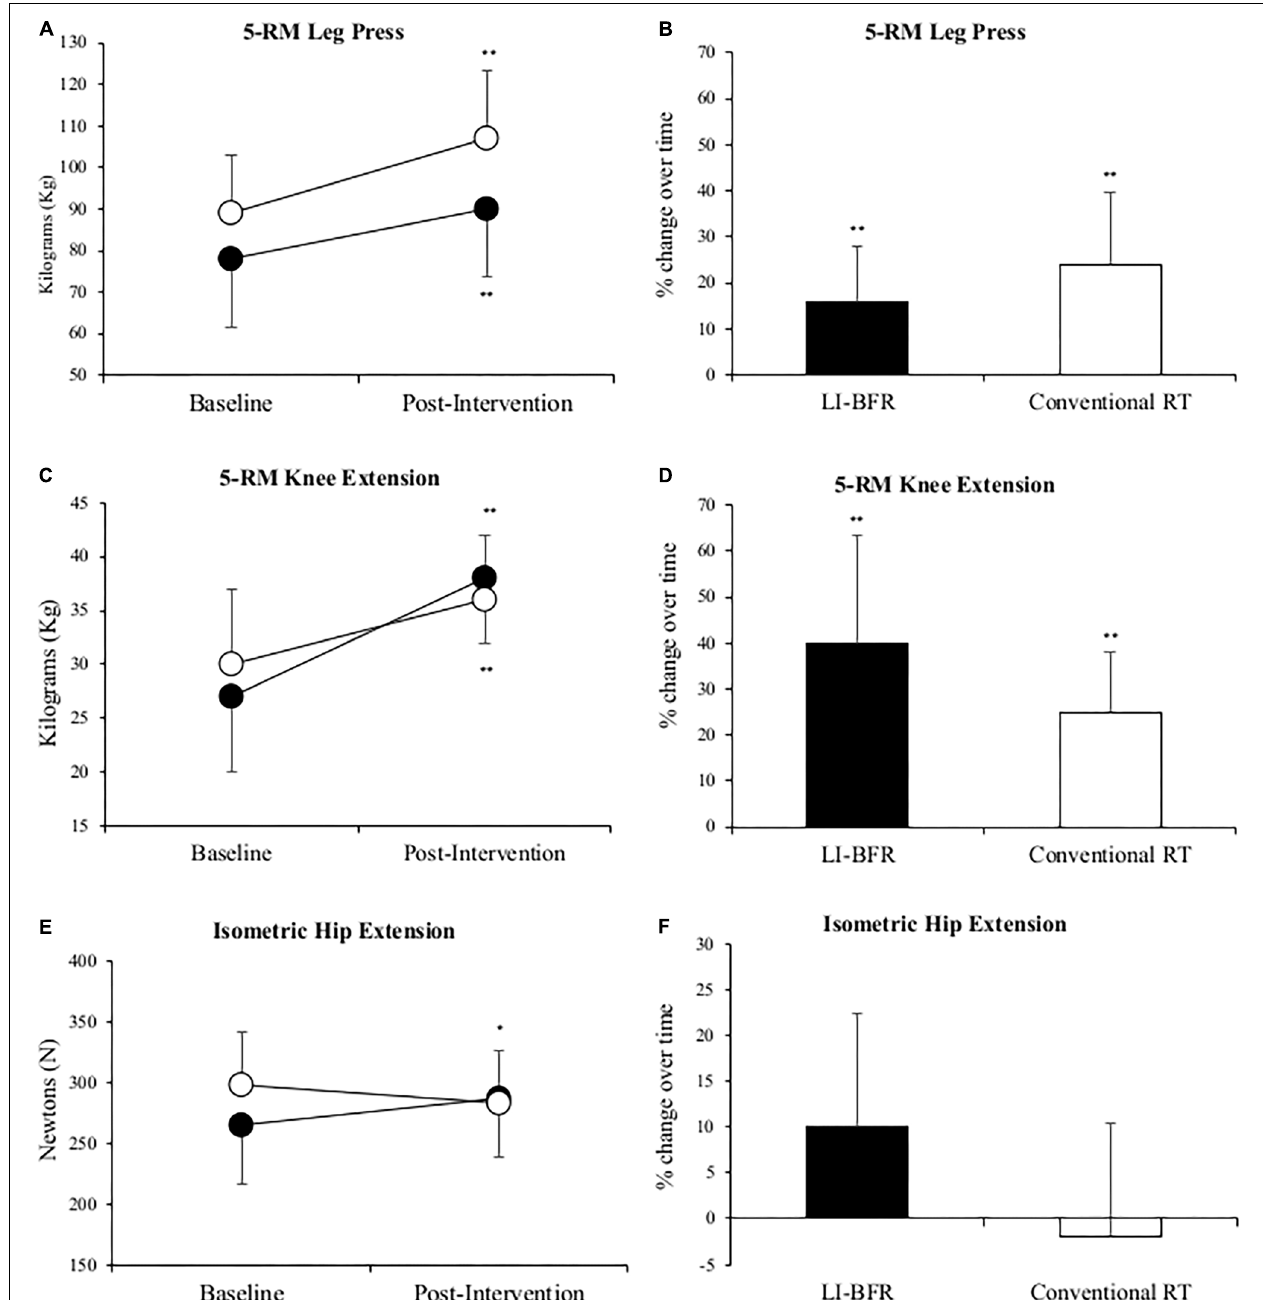
FIGURE 3 | Changes in 5-RM leg press (A,B) , 5-RM knee extension (C,D) and isometric hip extension (E,F) at baseline and after 3-weeks of rehabilitation. Black points LL-BFR group, White points Conventional Resistance Training (RT) group. Bar charts show group percent changes over time. Data is expressed as mean ± SD. ∗ p < 0.05 and ∗∗ p < 0.01 versus baseline measurement. Data refers to primary injured limb. LL-BFR, low-load blood flow restriction; RT, resistance training; RM, repetition